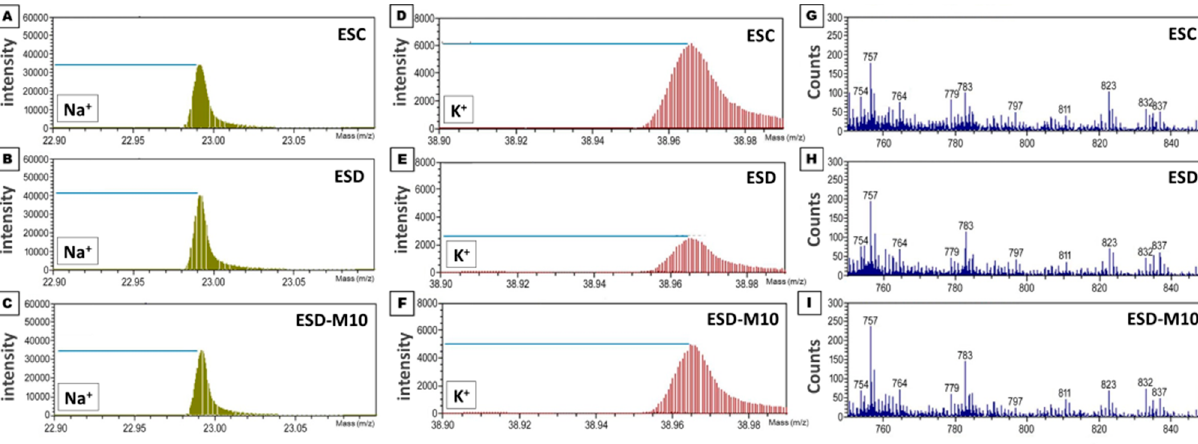
Figure 2. Melatonin restores the trans-membrane ionic gradient following ESD injury. TOF-SIMS positive spectra show the hippocampal Na + and K + expressions in the ESC group ( A , D ), ESD group ( B , E ), and ESD-M10 group ( C , F ). Note that in ESD rats, increases in hippocampal Na + expression were more significant than in ESC and ESD-M10 rats ( p < 0.05), but K + expression was significantly reduced when compared with the other two groups ( p < 0.05). Paraformaldehyde was used for mass calibration with a set of standard peaks to improve the effect of ion spectra on the substrate ( G – I ).